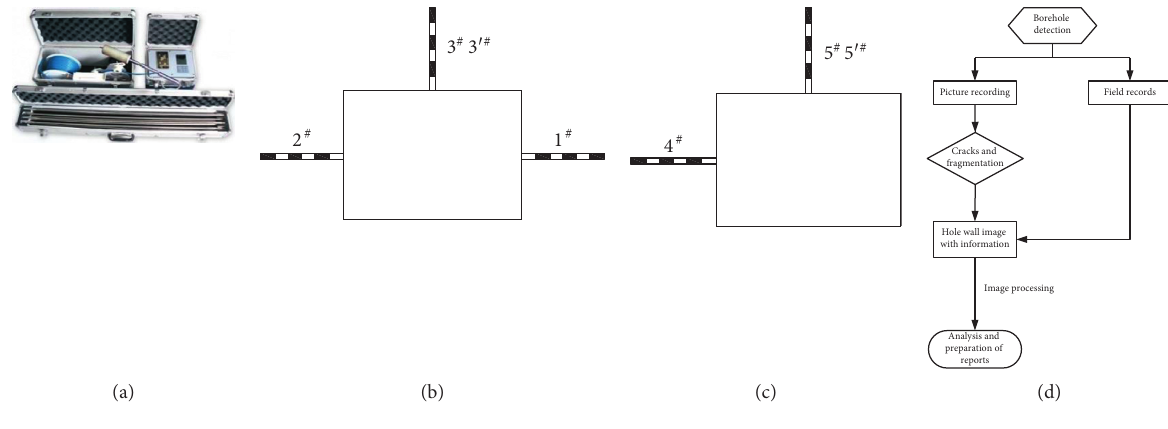
Figure 9: The detection scheme of the surrounding rock structure. Table 7: The instrument